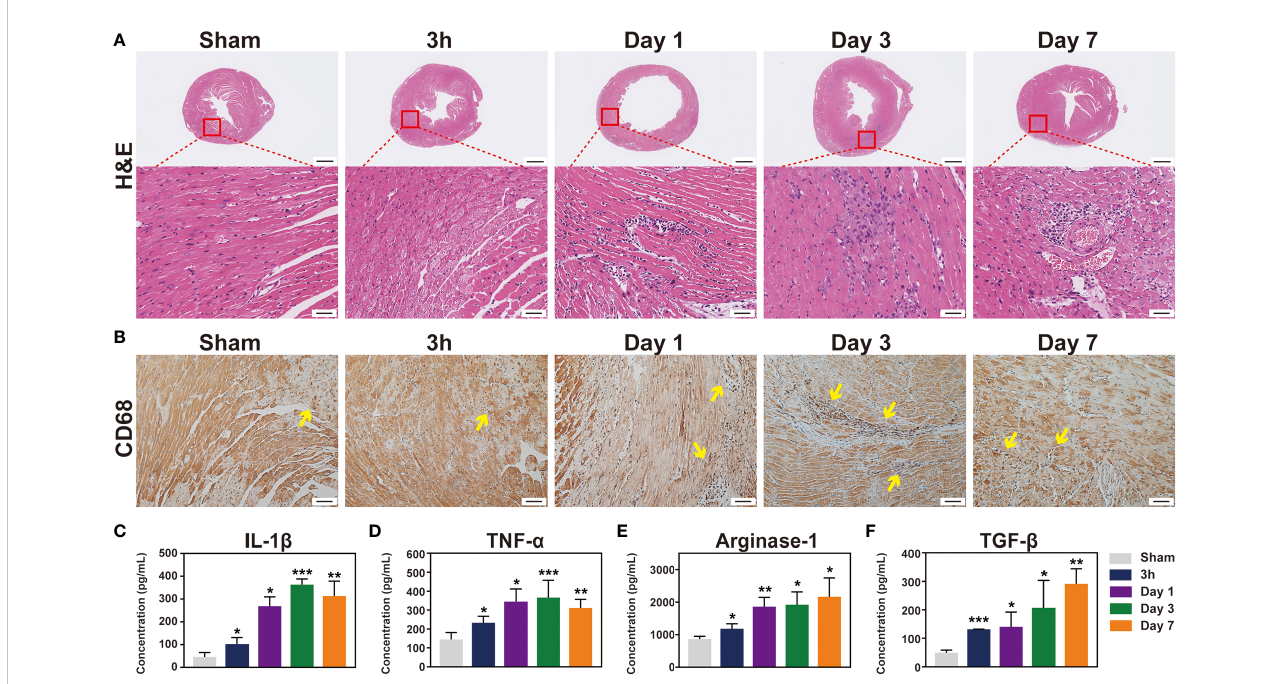
FIGURE 3 T2-weighted imaging sequence detect in fl ammation signal in the mouse heart during the fi rst week post-IR. (A) , one mouse equipped with ECG ( ☆ ) and respiratory ( ◇ ) are being prepared to scan under 7.0 T MRI. (B) , real-time ECG and respiratory rate in a mouse. (C) , the typical T2W images from the same mouse before and after IR. (D) , quantitative the mean T2W signal intensity of the LV myocardium in each group, (n = 5). *p < 0.05 VS. Sham, ** p < 0.01, *** p <